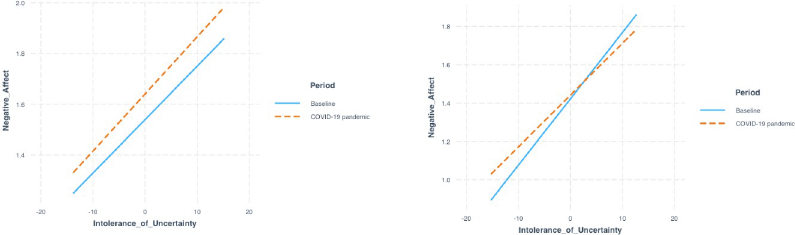
Fig 2. Association between negative affect and IU grouped per period for parents (left) and adolescents (right).